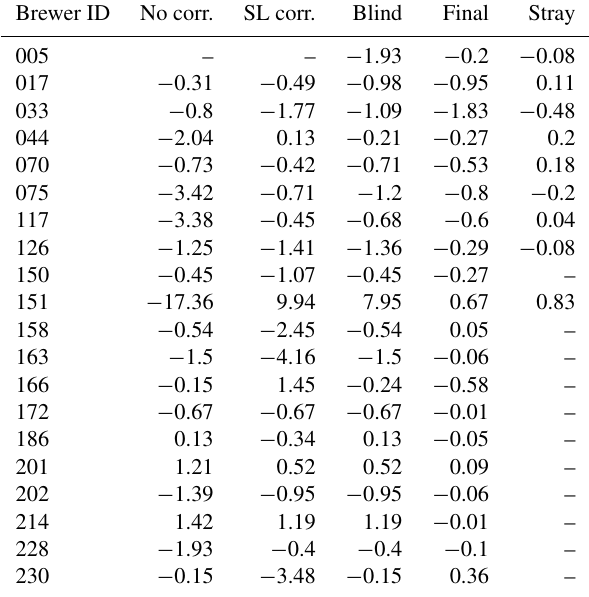
Table 3. Summary of mean percentage difference before calibra- tion, without and with standard lamp correction, and after the cali- bration, on the last column with the stray light correction applied.